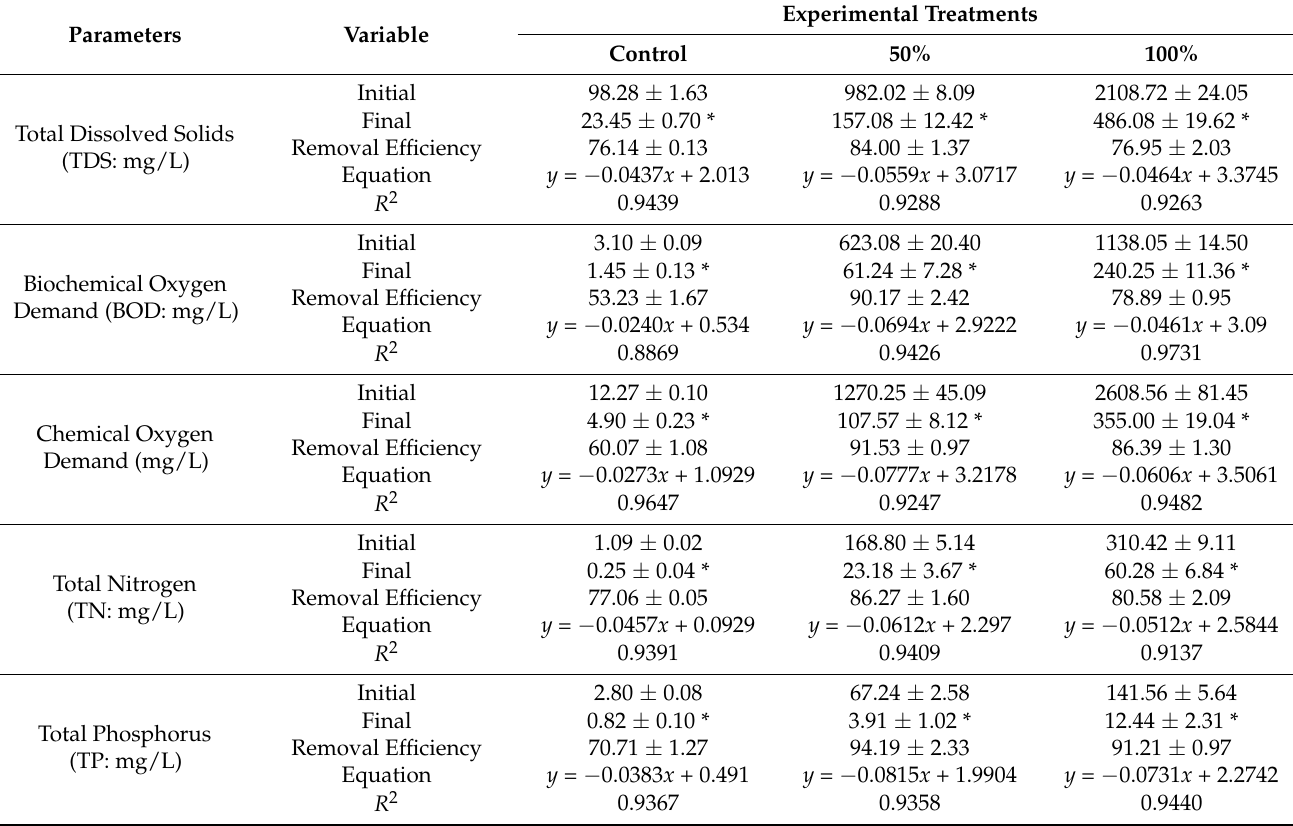
Figure 6. FTIR spectra of C. vulgaris biomass cultivated in different concentrations of mushroom farm wastewater (WW: wastewater). Table 3. Kinetic parameters of C. vulgaris in different wastewater